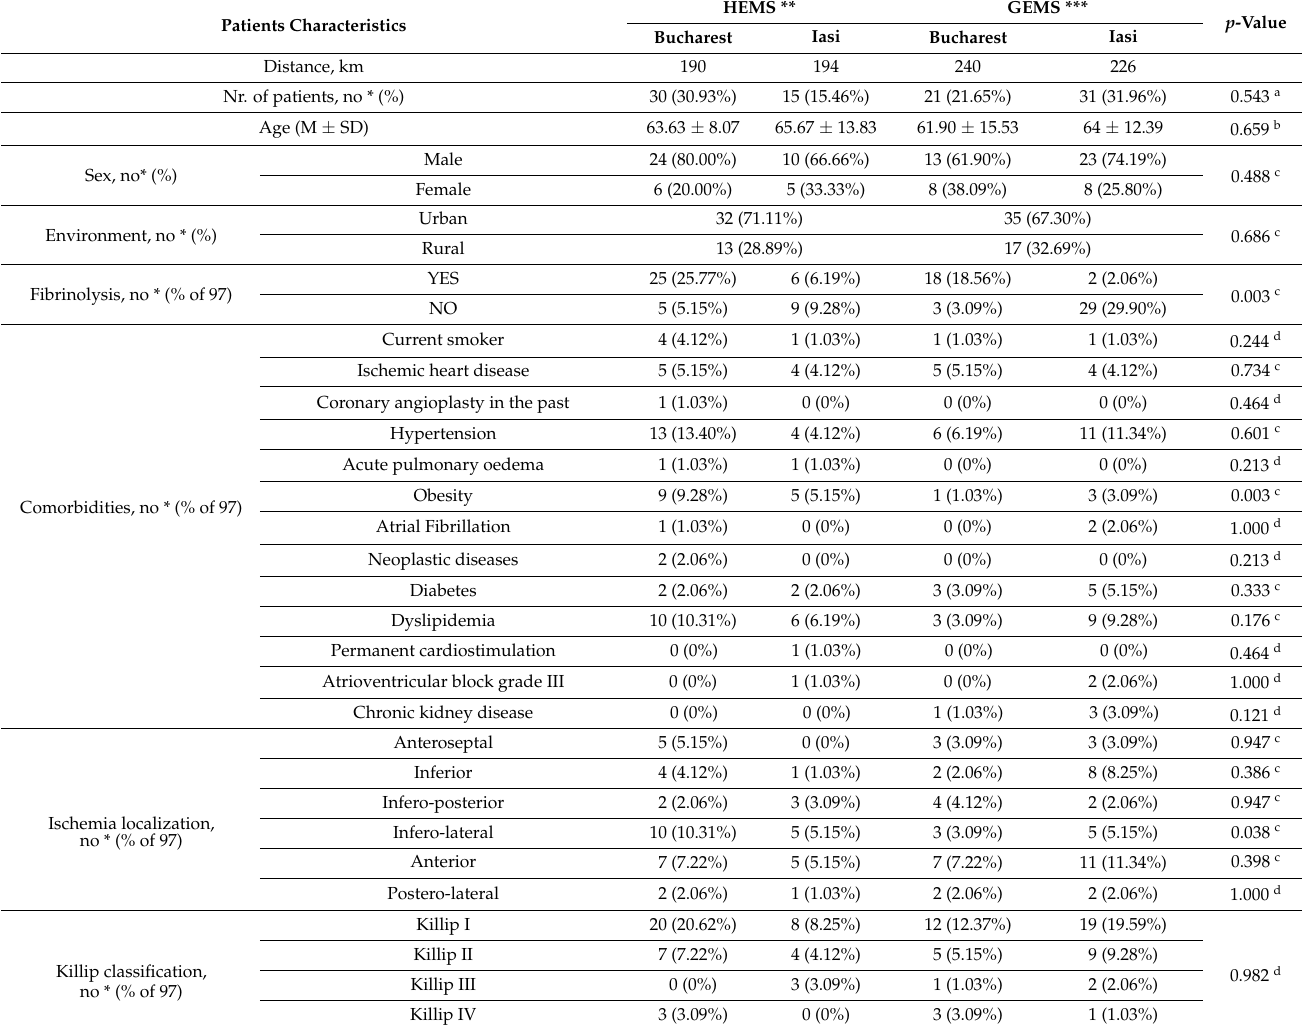
Table 1. Characteristics of the study